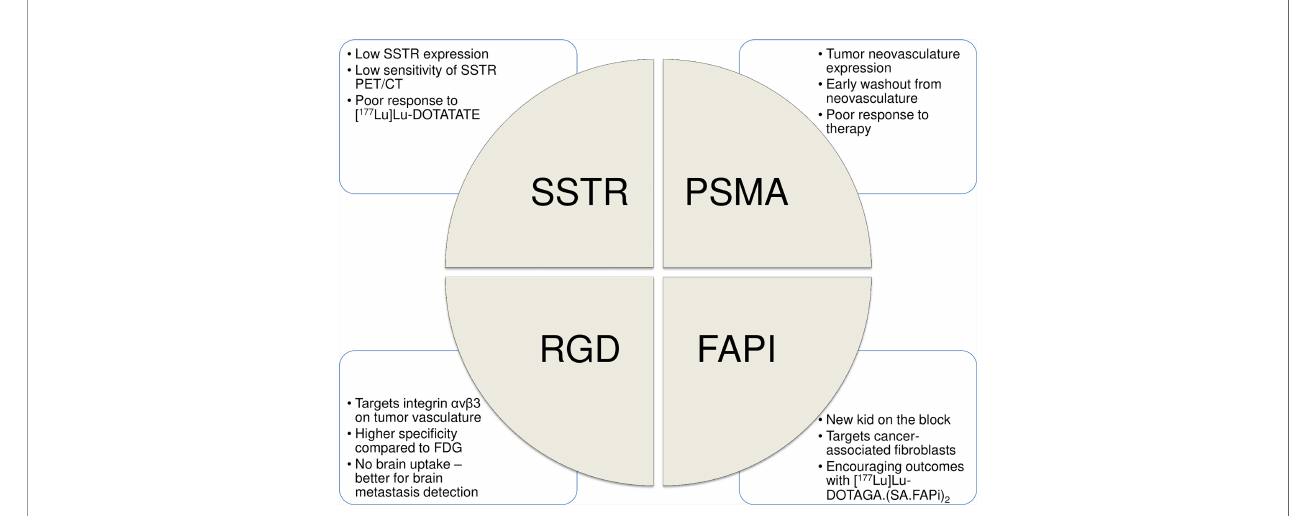
FIGURE 1 | An overview of the currently available theranostic strategies for